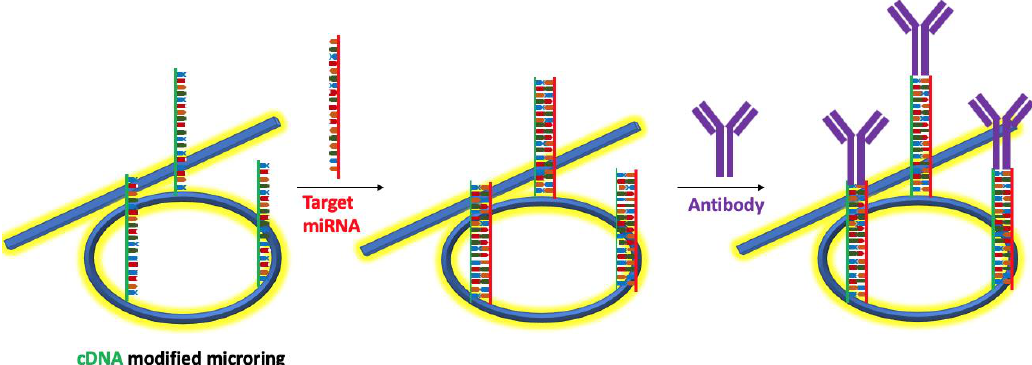
Figure 19. Schematic diagram of the Anti-DNA-RNA amplification experiment. A complementary DNA modified microring is exposed to target miRNA followed by the anti-DNA-RNA antibody for signal amplification.